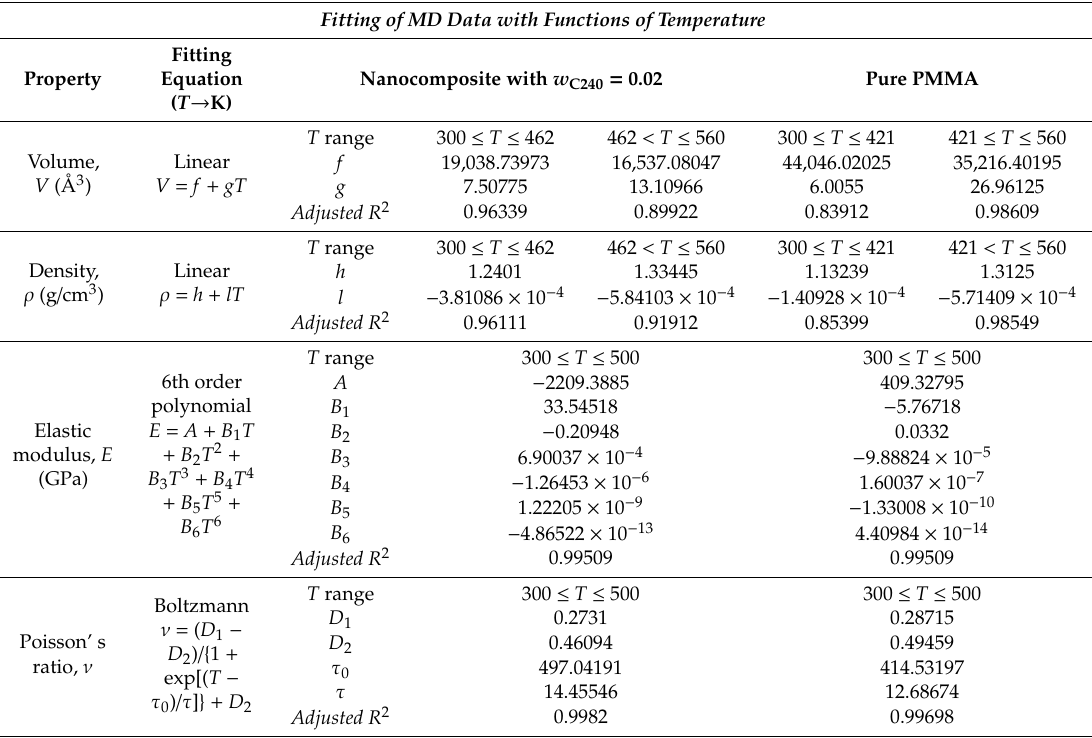
Figure 8. Volume of the pure PMMA and nanocomposite with w C240 = 0.2 with respect to temperature and the corresponding glass transition temperatures T g arisen from the intersection of appropriate linear fittings. Table 1. Definition of all the fitting functions adopted throughout the